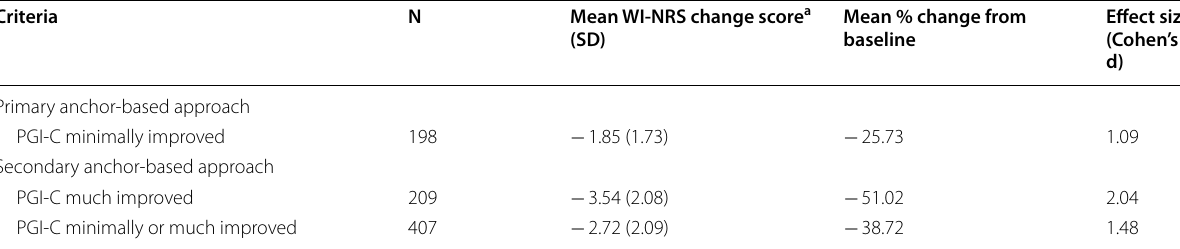
PGI-C, Patient global impression of change; SD, standard deviation; WI-NRS, Worst Itching Intensity Numerical Rating Scale